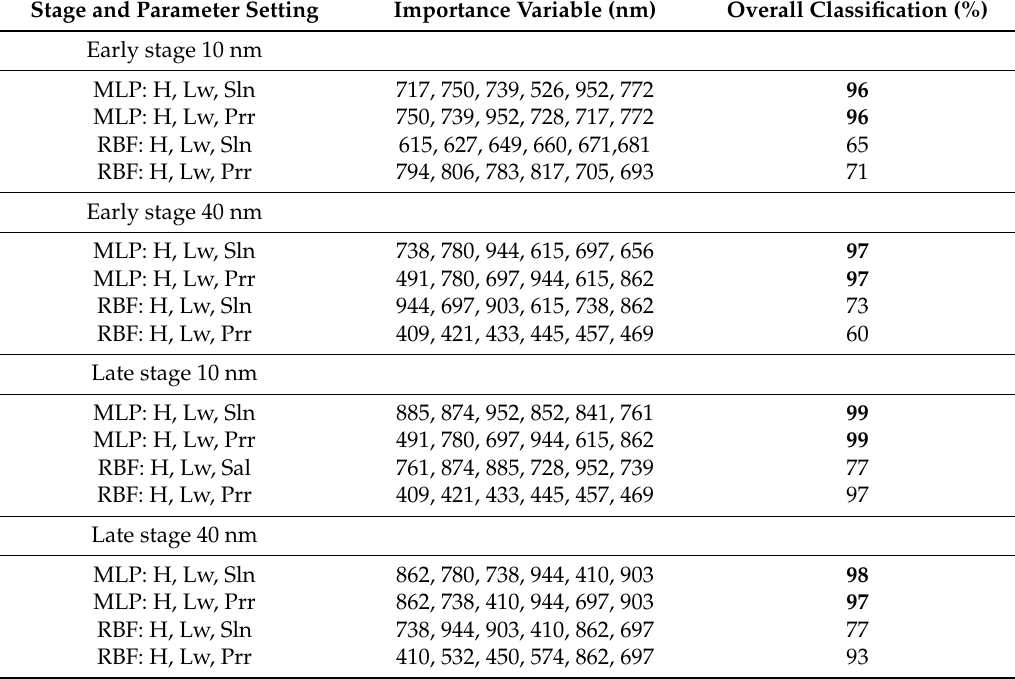
Table 1. Hyperspectral classification of healthy (H), laurel wilt (Lw) disease, Phytophthora root rot (Prr), and salinity damage (Sln) in avocado and best wavebands selection using multilayer perceptron (MLP) and radial basis function (RBF) classification for different growth stages.